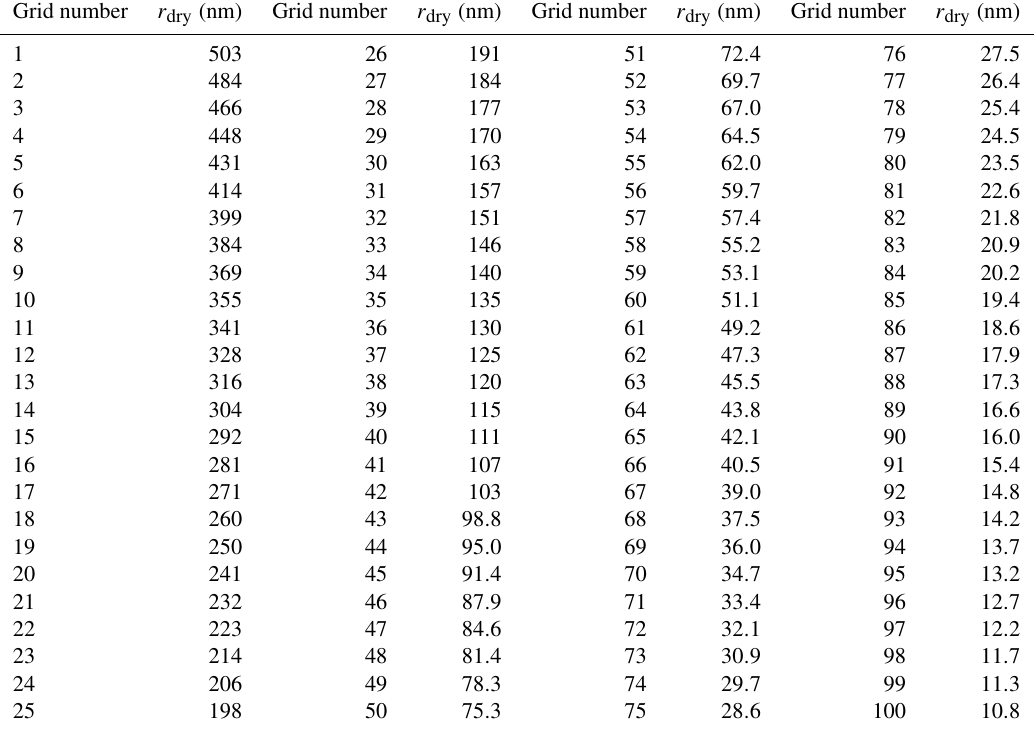
Table 1. Initial dry aerosol radii for different